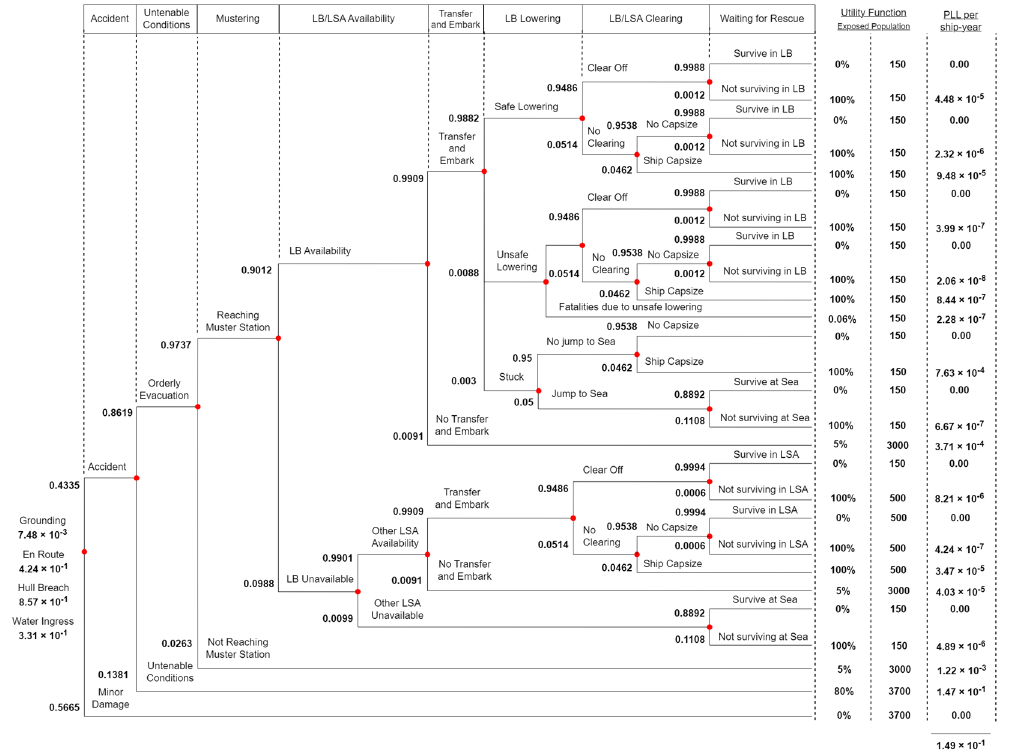
Figure A12. Event tree calculations and results for the baseline scenario of grounding accidents.